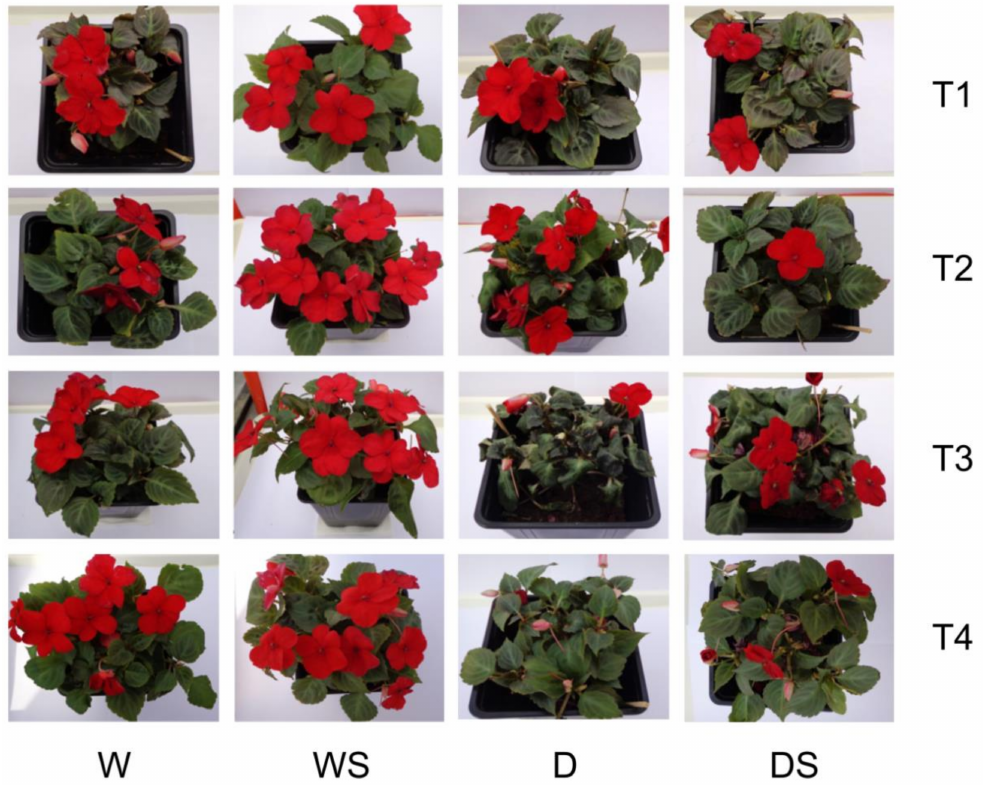
Figure 2. Appearance of the four test groups of plants at di ff erent time points. watered plants (W); drought-stressed plants (D); watered plants treated with salicylic acid (SA) (WS); drought-stressed plants treated with SA (DS). T1–T4 are di ff erent time points as indicated in Figure